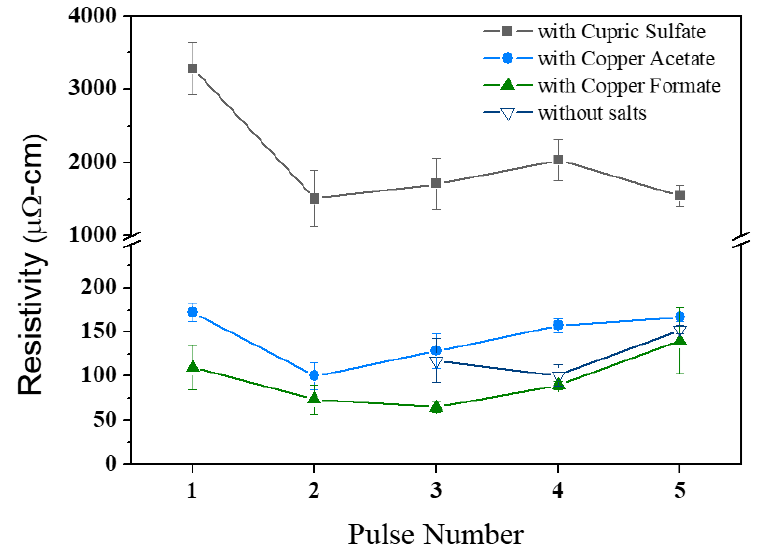
Figure 5. Resistivity of sintered hybrid copper pastes with various copper salt additives (and SMPO:NPO ratio of 3:1).